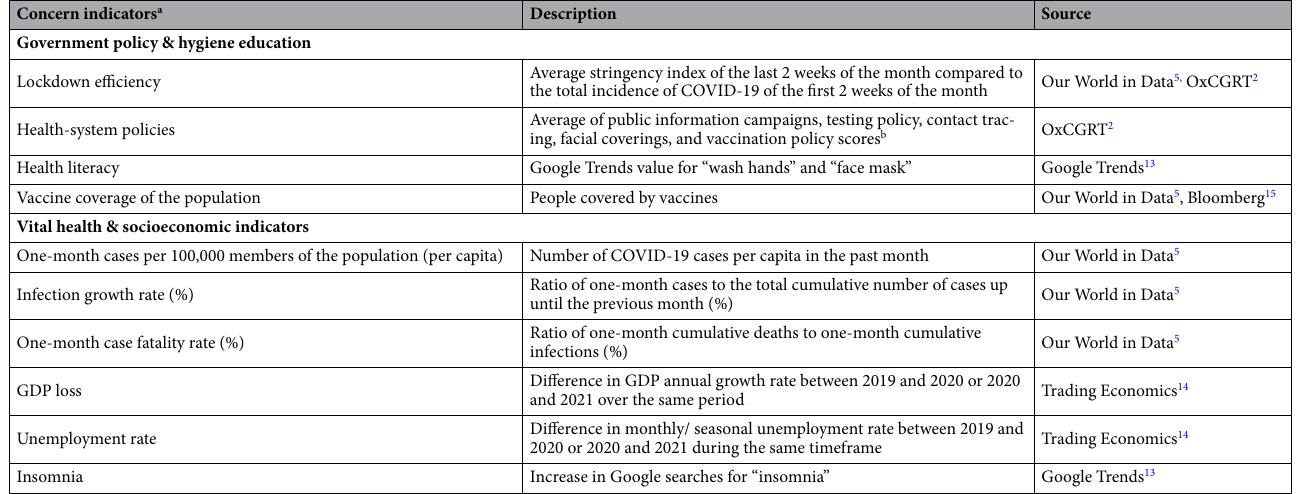
Table 1. Summary of 10 indicators included in the present analyses. a All indicators are updated monthly except for GDP loss, which is updated quarterly, and the unemployment increase rate, which is updated monthly or quarterly. b Vaccination policy included in December 2020 and